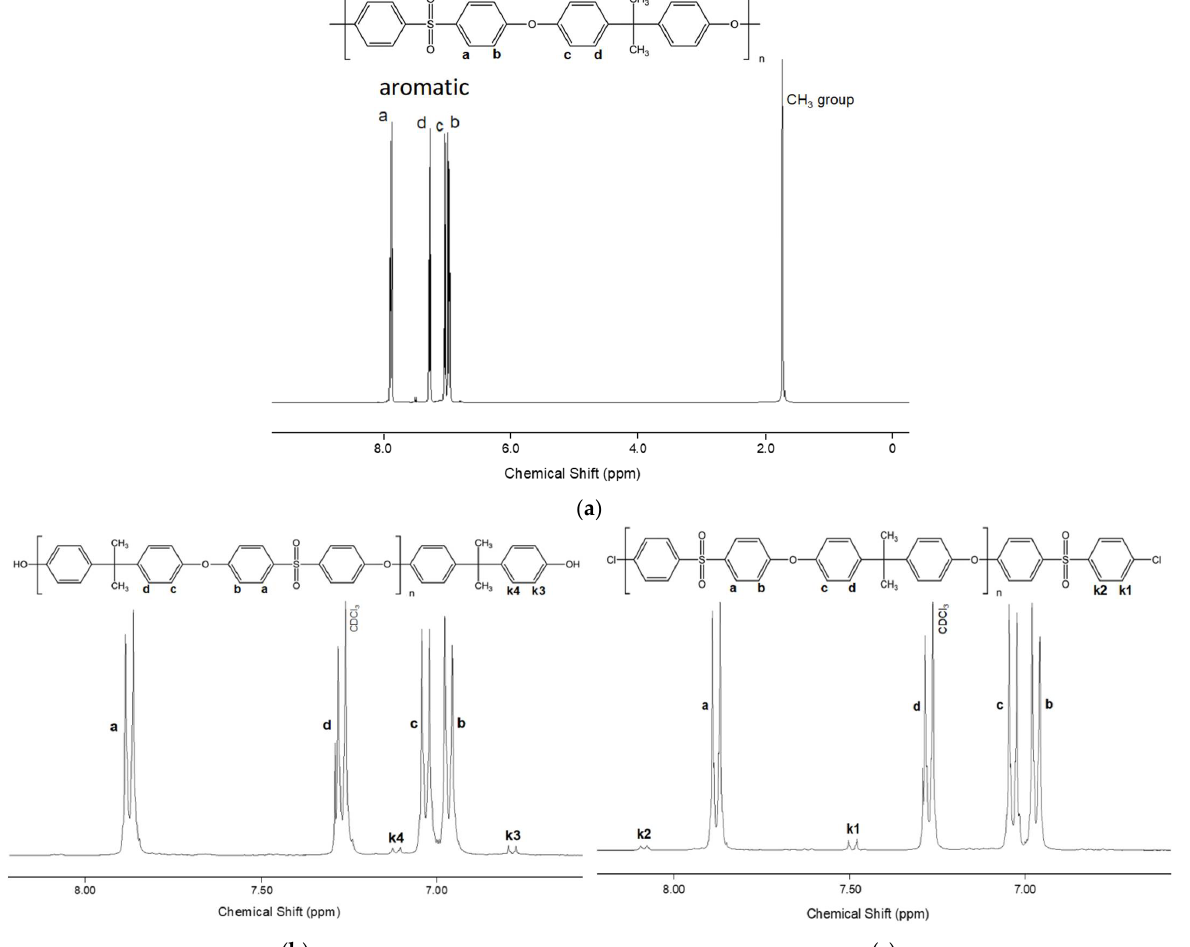
Figure 2. NMR spectra of the synthesized PSF with different terminal groups: ( a ) general view of the PSF spectrum, ( b ) –OH groups, ( c ) –Cl groups.